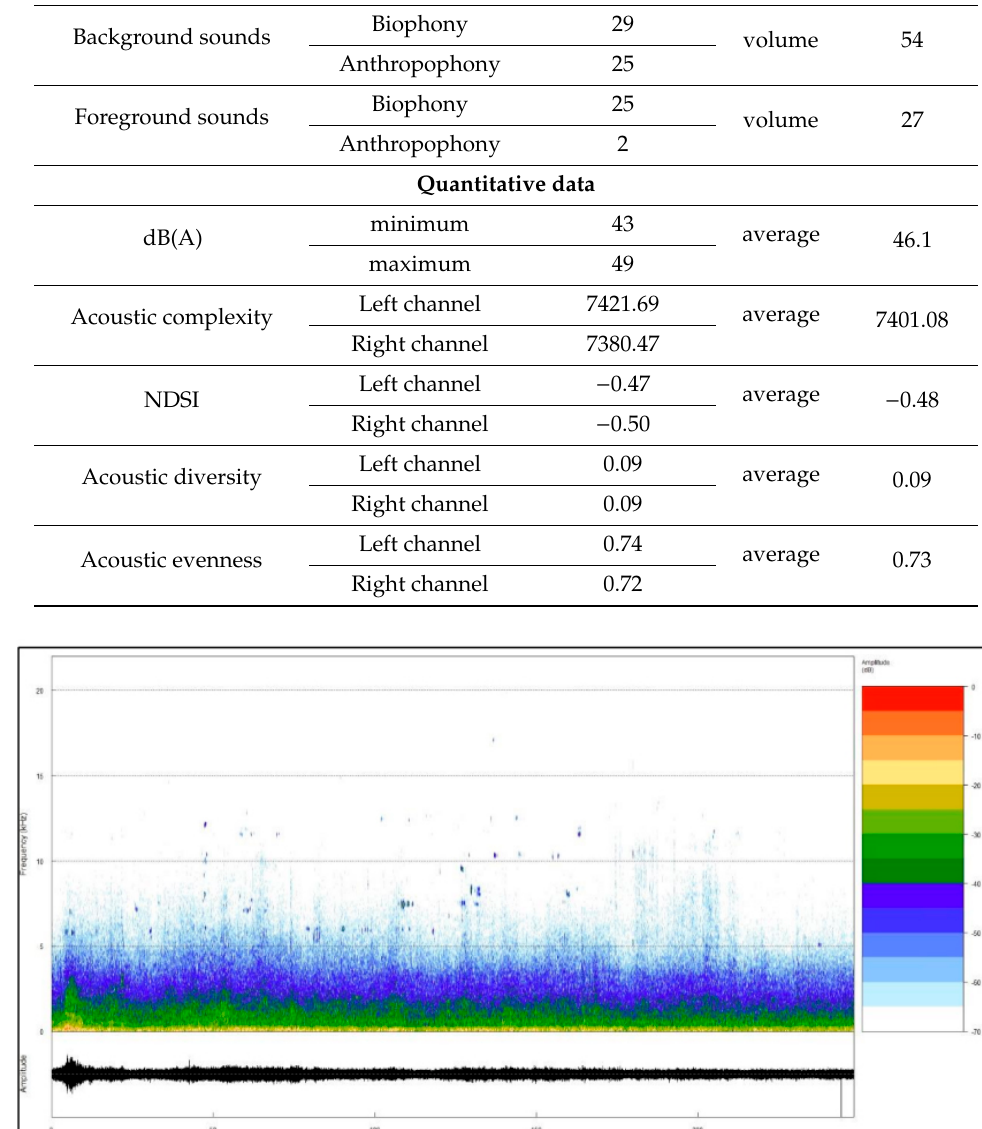
Figure 7. The spectrogram analysis of the Hagia Sophia Square sound recording. Despite the fact that low frequencies prevailed in the spectrum, an advanced complexity was noticeable in the high- frequency range.